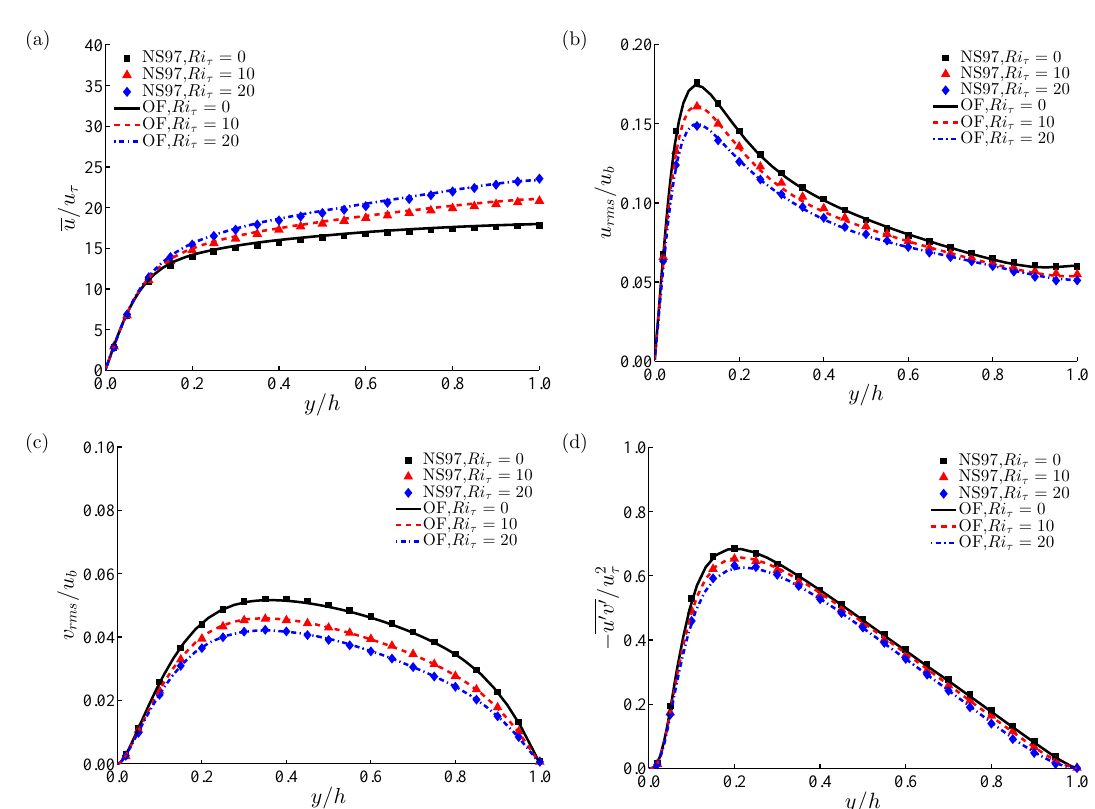
Figure A1. Comparisons of variables for neutral and stratified flows, Ri τ = 0, 10, 20. The lines are the results by current solver (OF), and the symbols are results from Nagaosa and Saito (1997) (NS97). (a) Mean velocity, (b) rms streamwise velocity, (c) rms vertical velocity, and (d) turbulent momentum